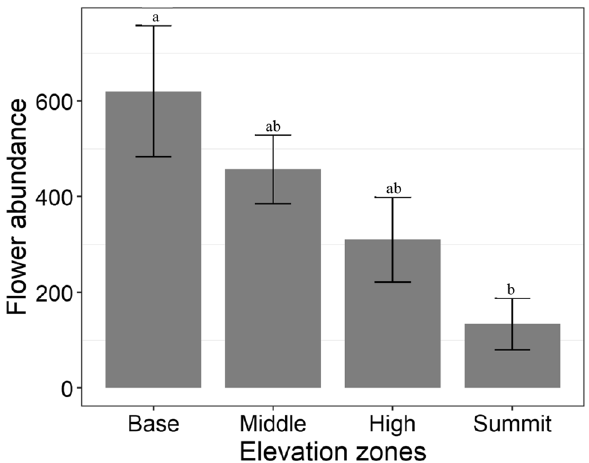
Figure 2. Mean flower abundance (± SE) among elevation zones. Bars with common letters are not significantly different at p > 0.05.